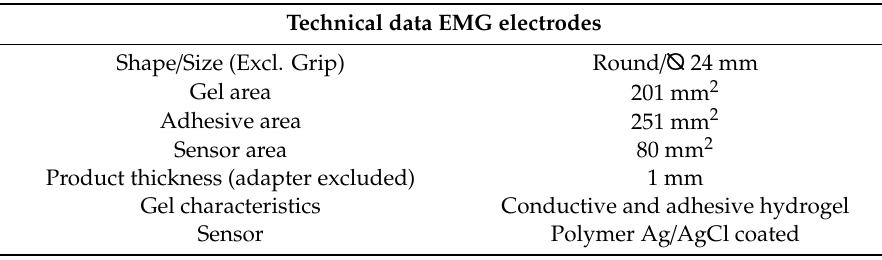
Table 5. Technical data of the EMG electrodes.